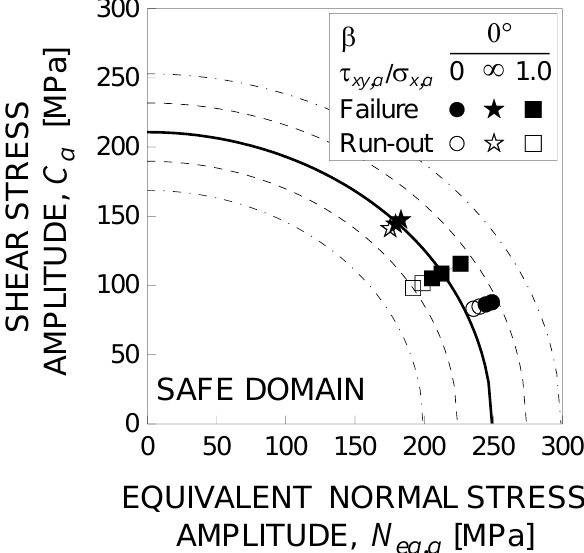
Figure 4. Shear stress amplitude vs. equivalent normal stress amplitude acting on the critical plane for EN-GJS-600-3 DCI.